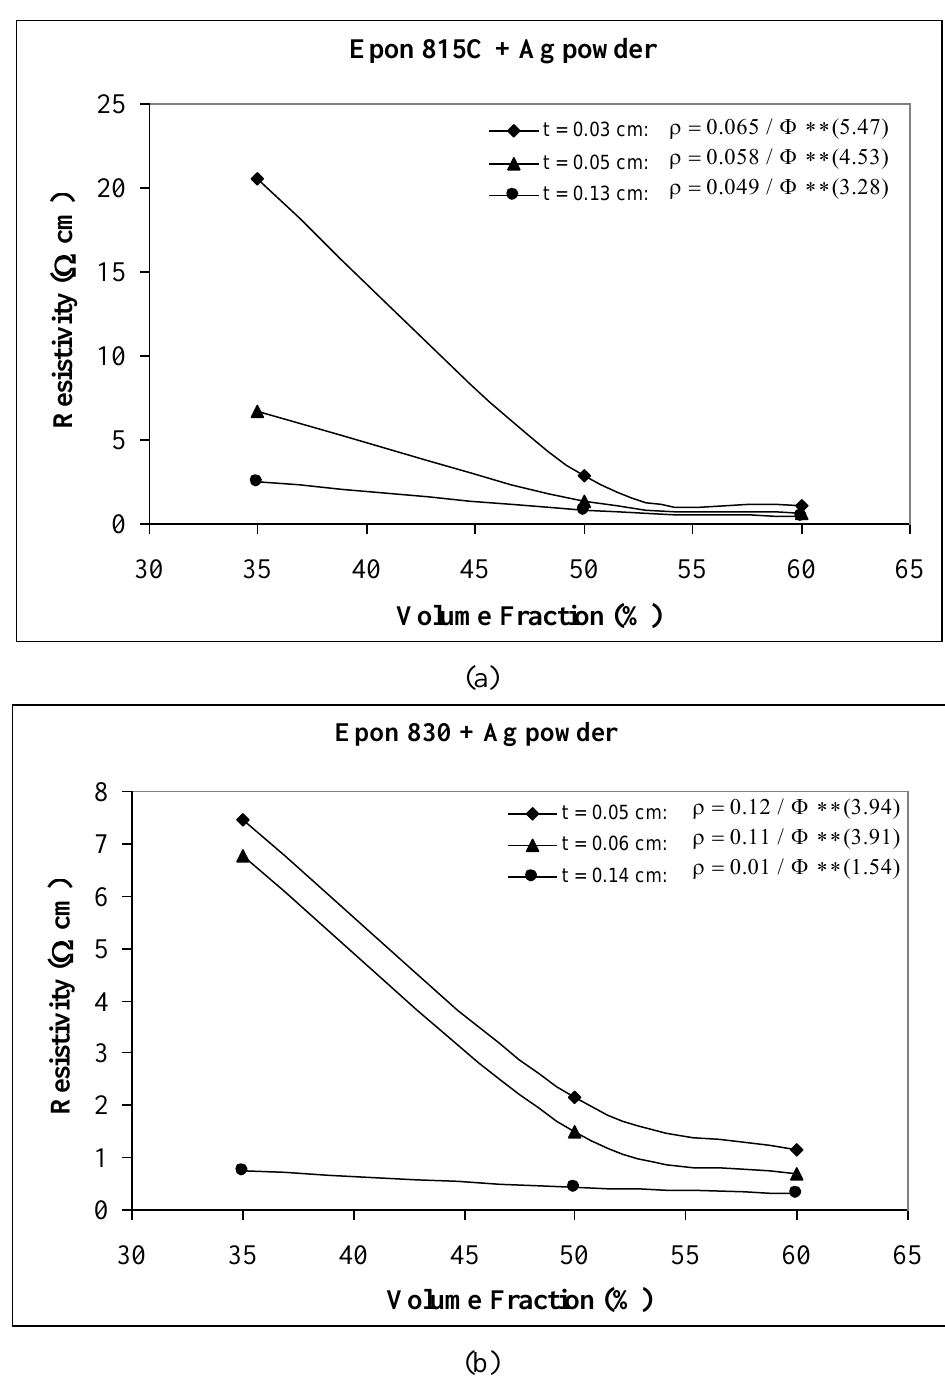
Figure 16. Volume fraction-thickness dependent resistivity of Epon 815C ( a ), and 830 ( b ) films filled with silver